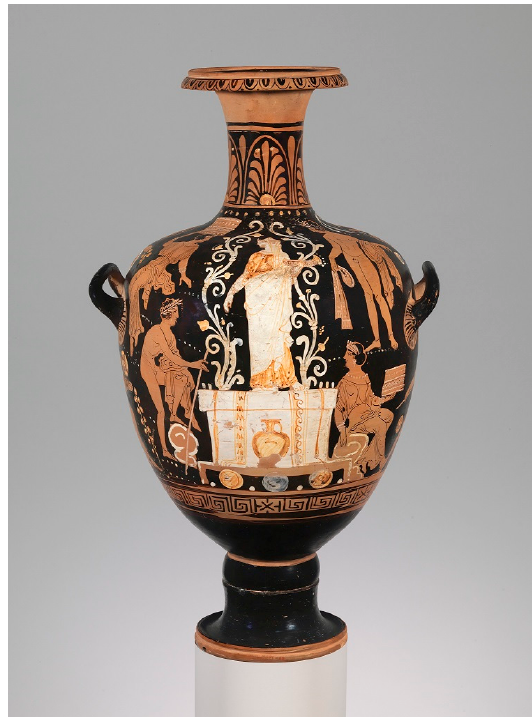
Figure 17. New York, Metropolitan Museum of Art 06.1021.230 Campanian hydria, Olcott Painter, ca. 360–330 B.C. Funerary statue of a bride within an arbor of tendrils flanked by youths and women. Image © The Metropolitan Museum of Art.